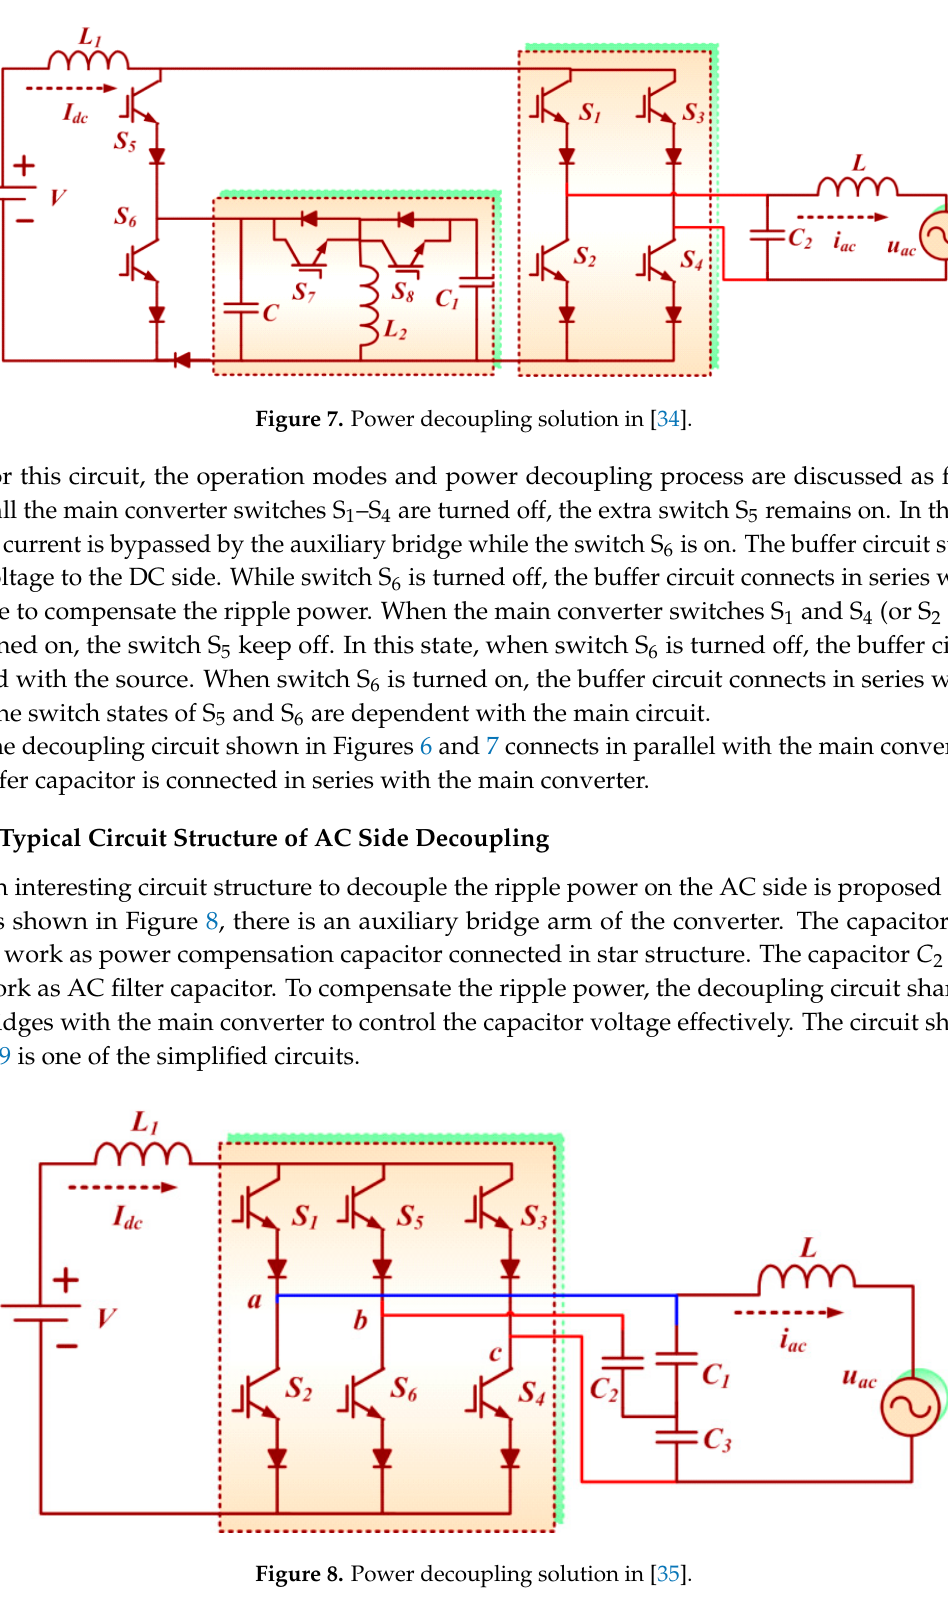
Figure 9. Power decoupling solution in [35]. The decoupling capacitor C 3 of Figure 8 can be seen as a wire in the circuit of Figure 9. The decoupling capacitor C 1 works as the AC filter capacitor.